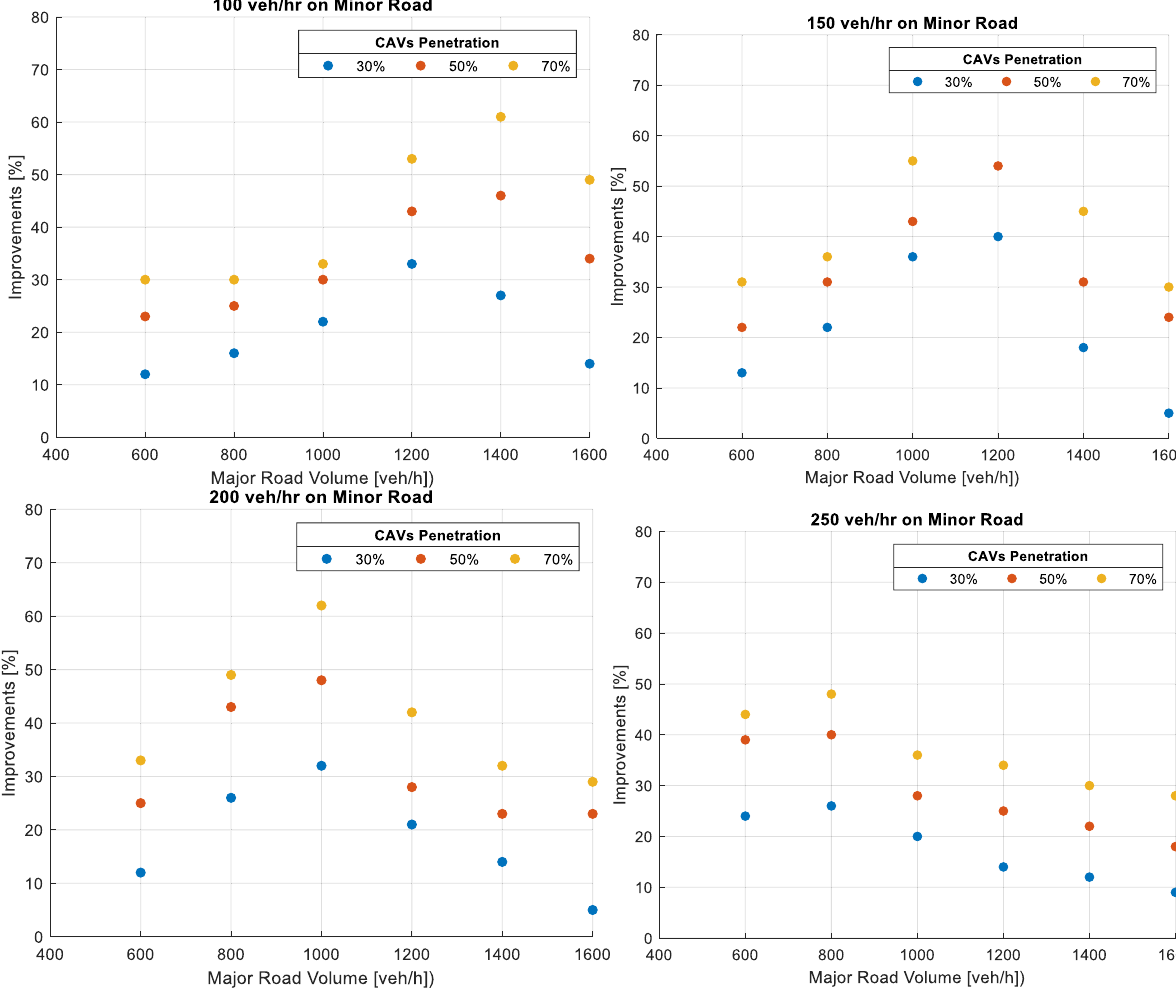
Figure 11: Improvement in delay for the minor road